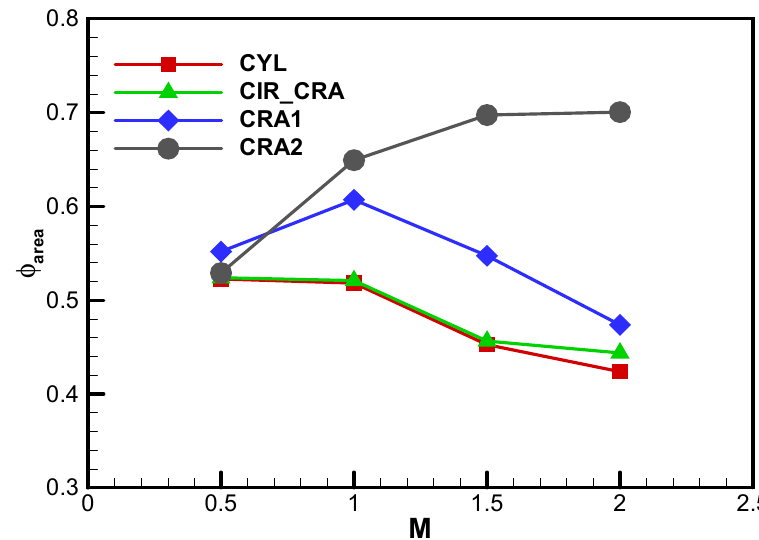
Figure 11. Area-averaged overall cooling effectiveness at M = 0.5–2.0.